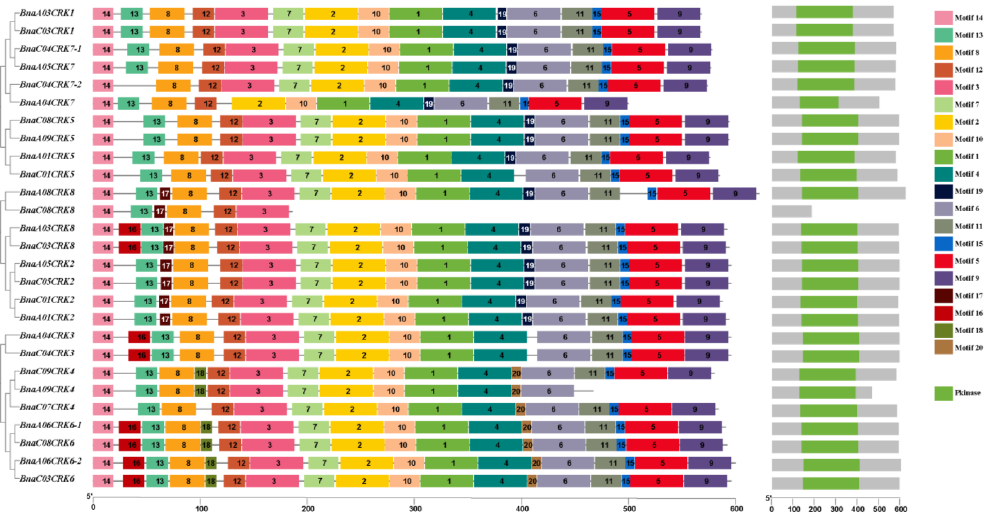
Figure 2. Conserved motif structure of the BnaCRK gene family. Different colors and numbers represented the 20 conserved motifs of the BnaCRKs . The logo of each motif was plotted in the supplementary Figure S2. The N-terminal PKINASE domain is indicated as a green-colored block.